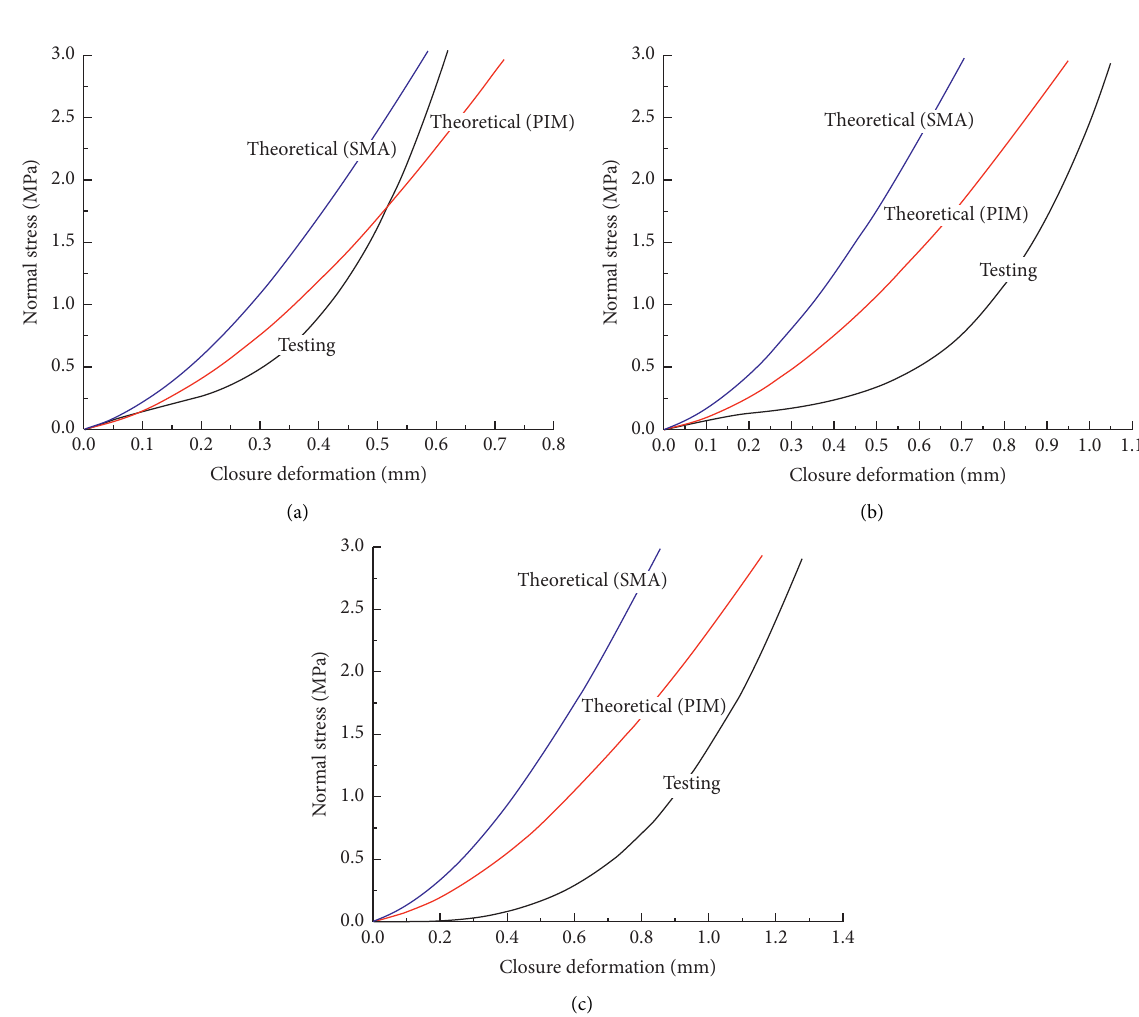
Figure 8: Comparison between experimental results and calculated curve. (a) J-I. (b) J-II. (c)